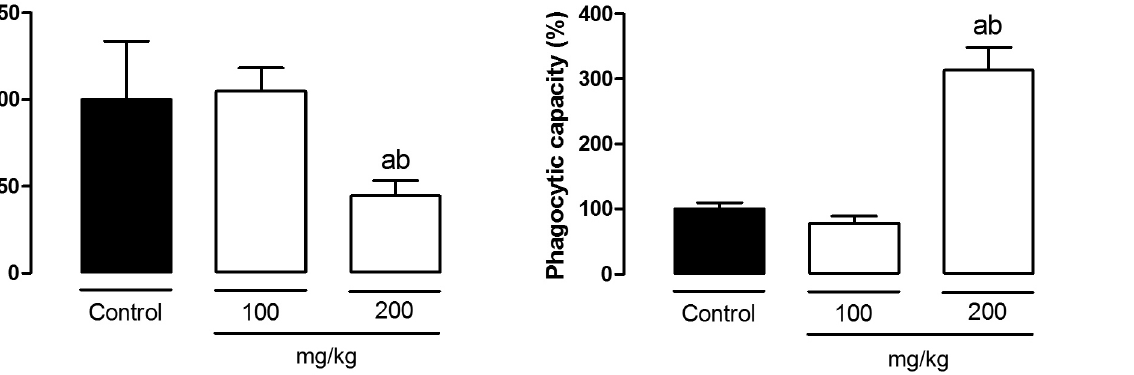
FIGURE 2 - Adhesion capacity of resident macrophages from mice fed regular chow (Control Group), treated with 100 mg/kg b.w. of CLD (Group 100), and 200 mg/kg b.w. (Group 200). a p<0.05 compared to Control. b p<0.05 compared to Group 100. Results are presented as % relative to Control.